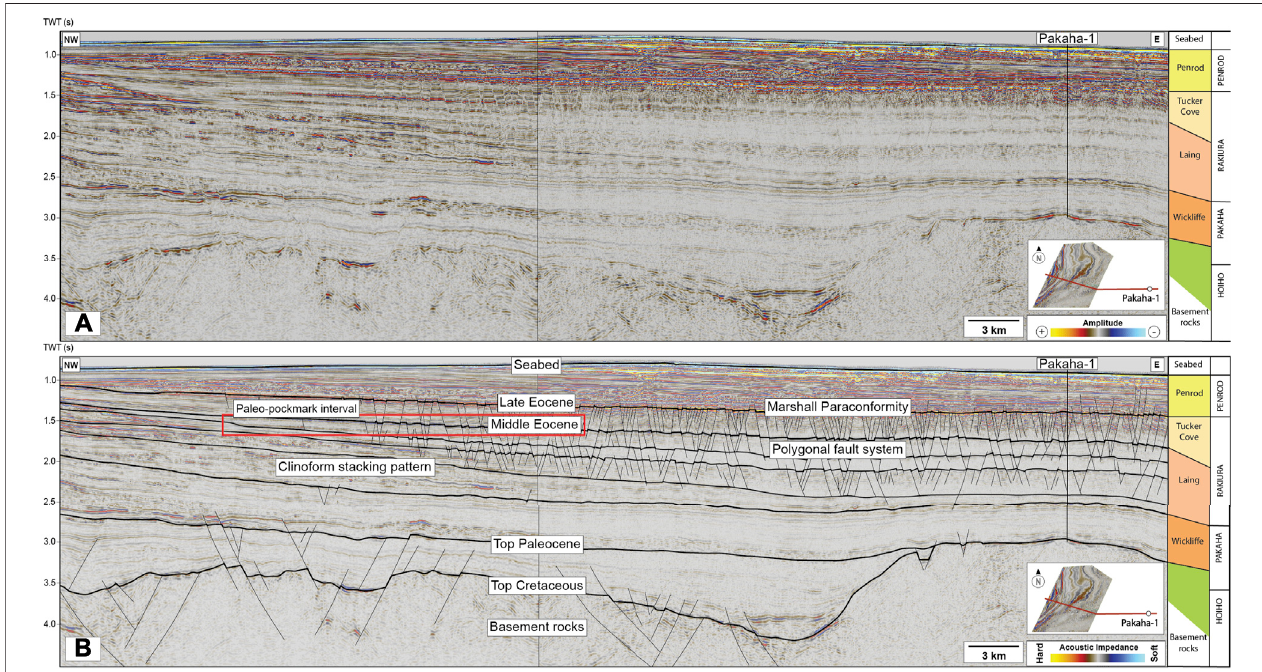
FIGURE 3 | Regional seismic line shows the seismo-stratigraphy and age correlation of the study area. The stratigraphic units are correlated from 2D seismic data and the Pakaha-1 well located outside the 3D seismic survey. The paleo-pockmarks are highlighted in the red rectangle and restricted to the Middle Eocene mudstone succession of the Laing Formation above a clinoform stacking pattern. See seismic pro fi le location in Figure 2 .